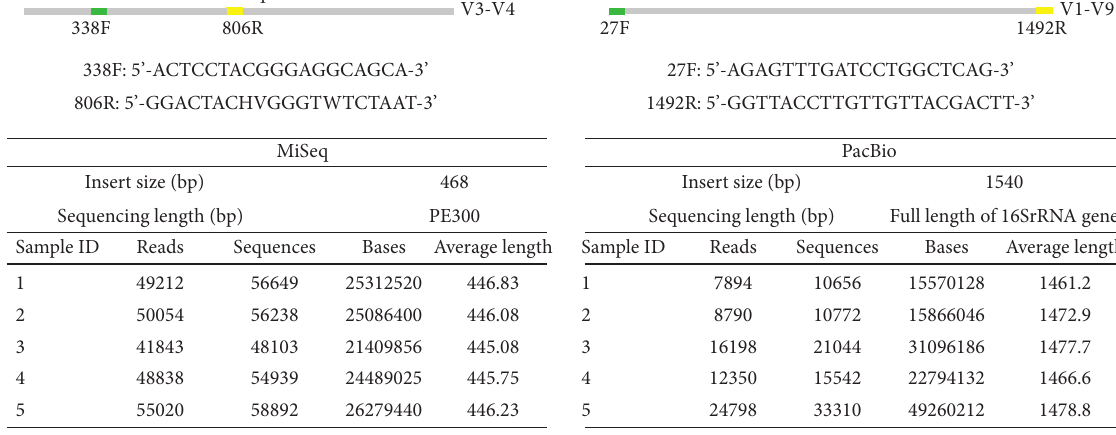
Figure 1: Sequencing results from 5 oral samples. Partial 16S amplicons (V3-V4) were sequenced on the Illumina/MiSeq; and full-length 16S amplicons (V1-V9) were sequenced on